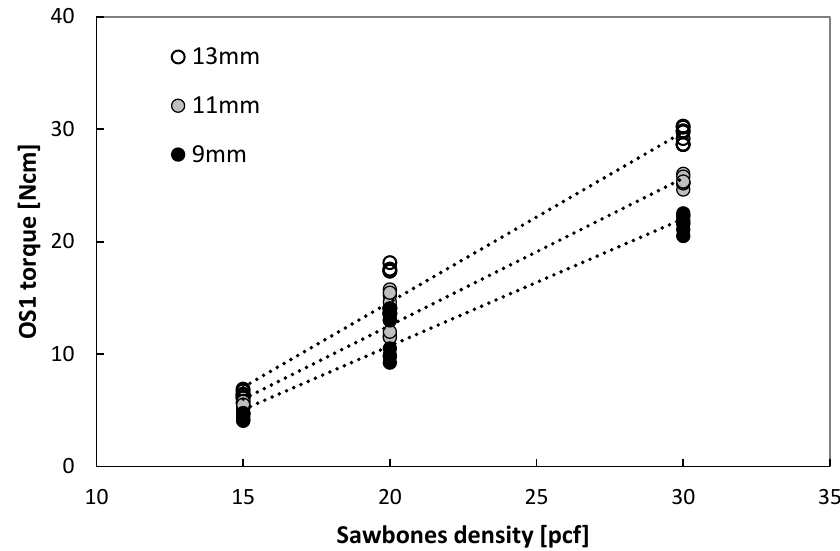
Figure 2. Linear regression of OS1 insertion torque in bone surrogate of di ff erent densities (pcf = pound per cubic foot).